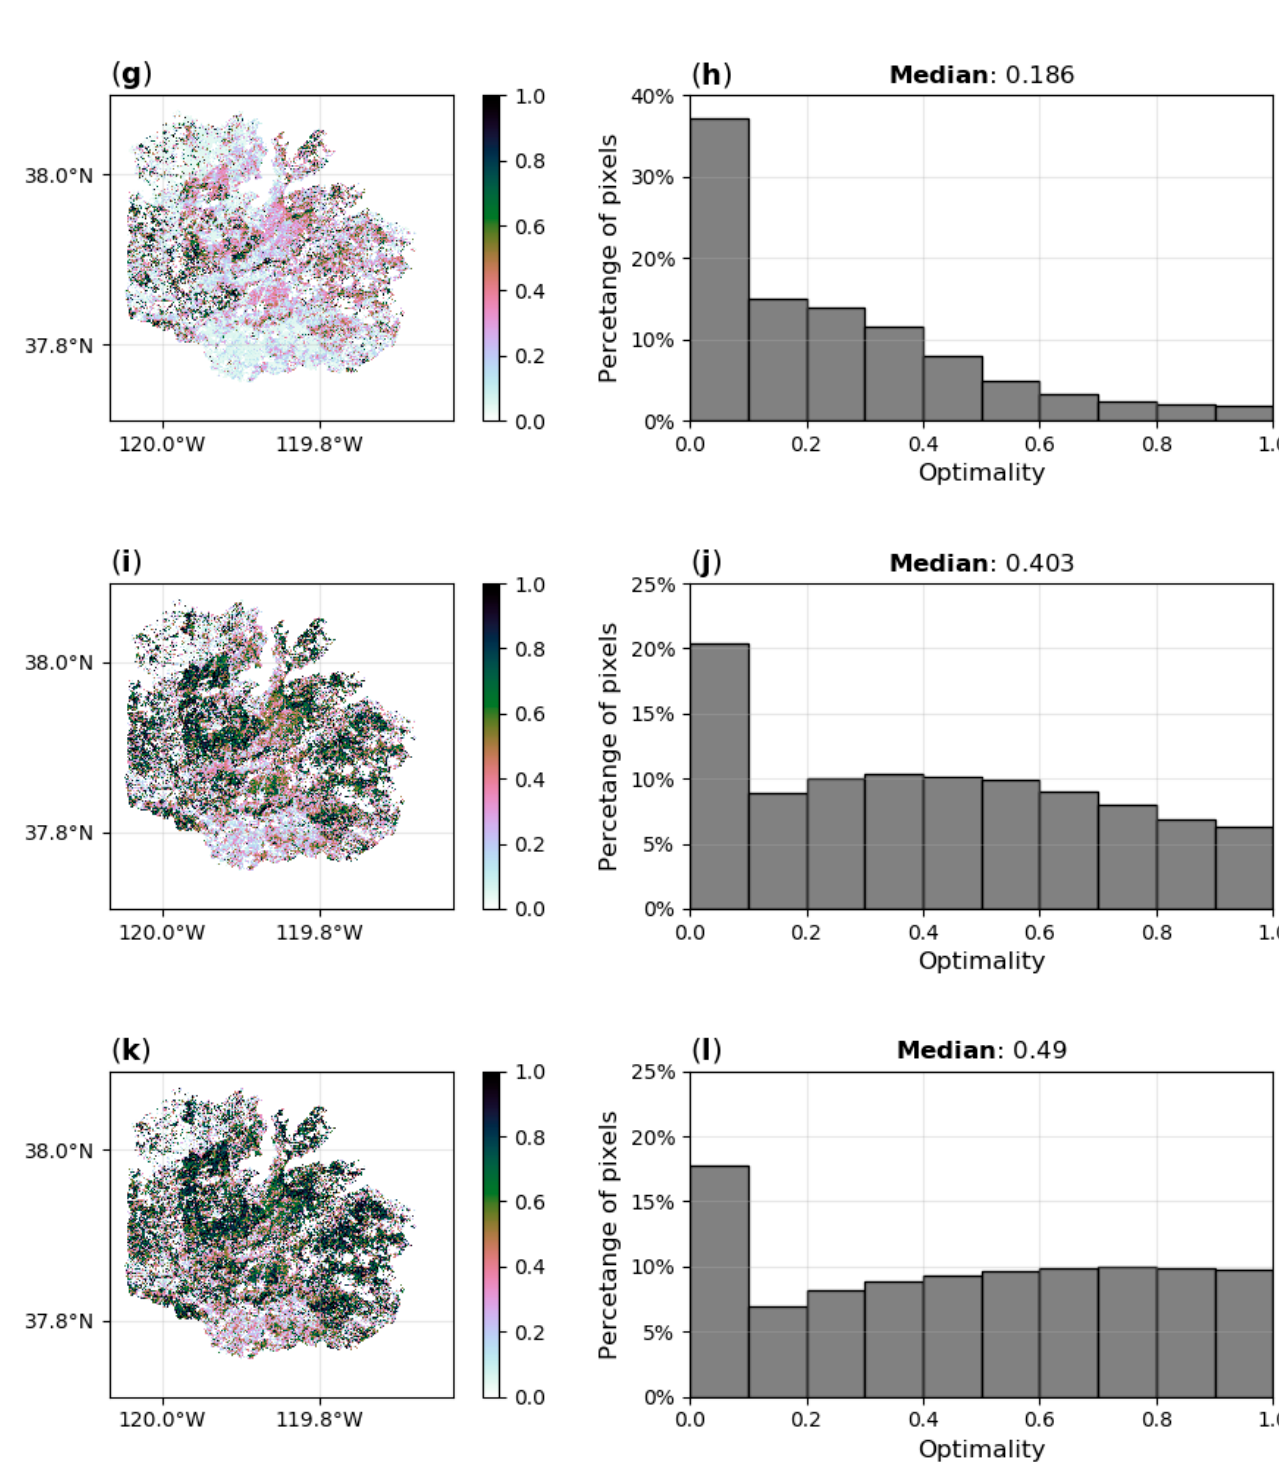
Figure 7. Optimality maps and histograms of the differenced normalized burn ratio (dNBR) indices for the Rim fire. ( a ) Optimality map dNBR 1 ; ( b ) Optimality map dNBR 2 ; ( c ) Optimality map dNBR 3 ; ( d ) Histogram of the dNBR 1 ; ( e ) Histo-gram of the dNBR 2 ; ( f ) Histogram of the dNBR 3 . Optimality maps and histograms of the differenced normalized difference vegetation index with mid infrared (dNDVI MID ) indices for the Rim fire. ( g ) Optimality map dNDVI MID,1 ; ( h ) Optimality map dNDVI MID,2 ; ( i ) Optimality map dNDVI MID,3 ; ( j ) Histogram of the dNDVI MID,1 ; ( k ) Histogram of the dNDVI MID,2 ; ( l ) Histogram of the dNDVI MID,3 .